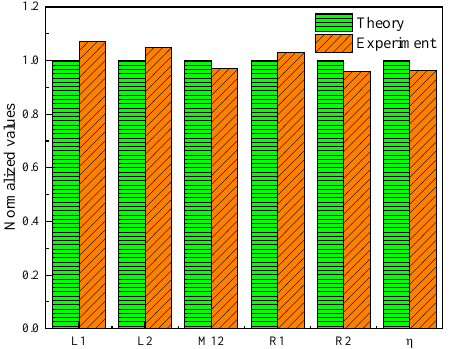
Figure 24. Comparison between experiment and theory.